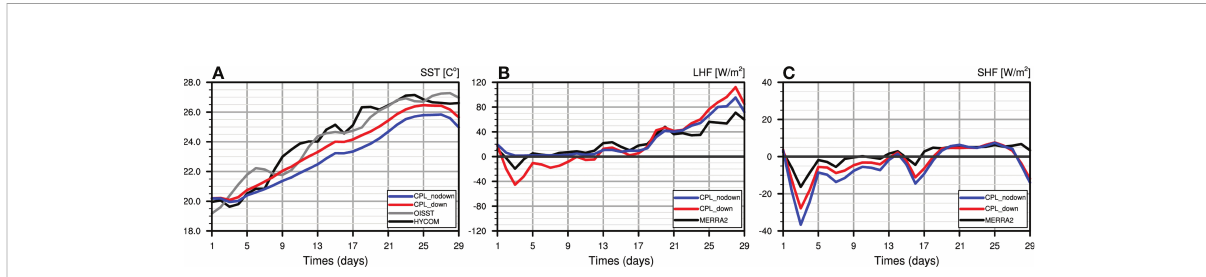
FIGURE 6 Time series plots of daily area-averaged mean values of sea surface temperature (SST) (A) , surface net latent heat fl ux (LHF) (B) , and surface net sensible heat fl ux (SHF) (C) time series for the reanalysis data (black), CPL_down (red) and CPL_nodown (blue) simulations, and the OISST data (grey in A only) over the analysis region (33.5 – 37.5° N, 124.0 – 131.0° E) for the 1994 case.